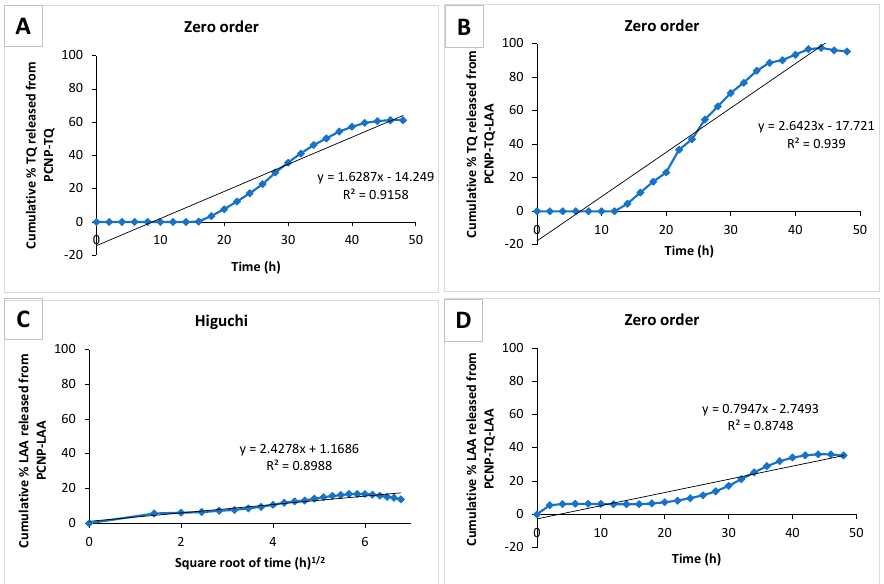
Figure 9. Release kinetics summary of TQ and LAA from all samples. ( A ) Release of TQ from PCNP-TQ, ( B ) release of TQ from PCNP-TQ-LAA, ( C ) release of LAA from PCNP-TQ-LAA and ( D ) release of LAA from PCNP-TQ-LAA. ( A , B , D ) follow zero-order release kinetics, while ( C ) follows the Higuchi release kinetic.